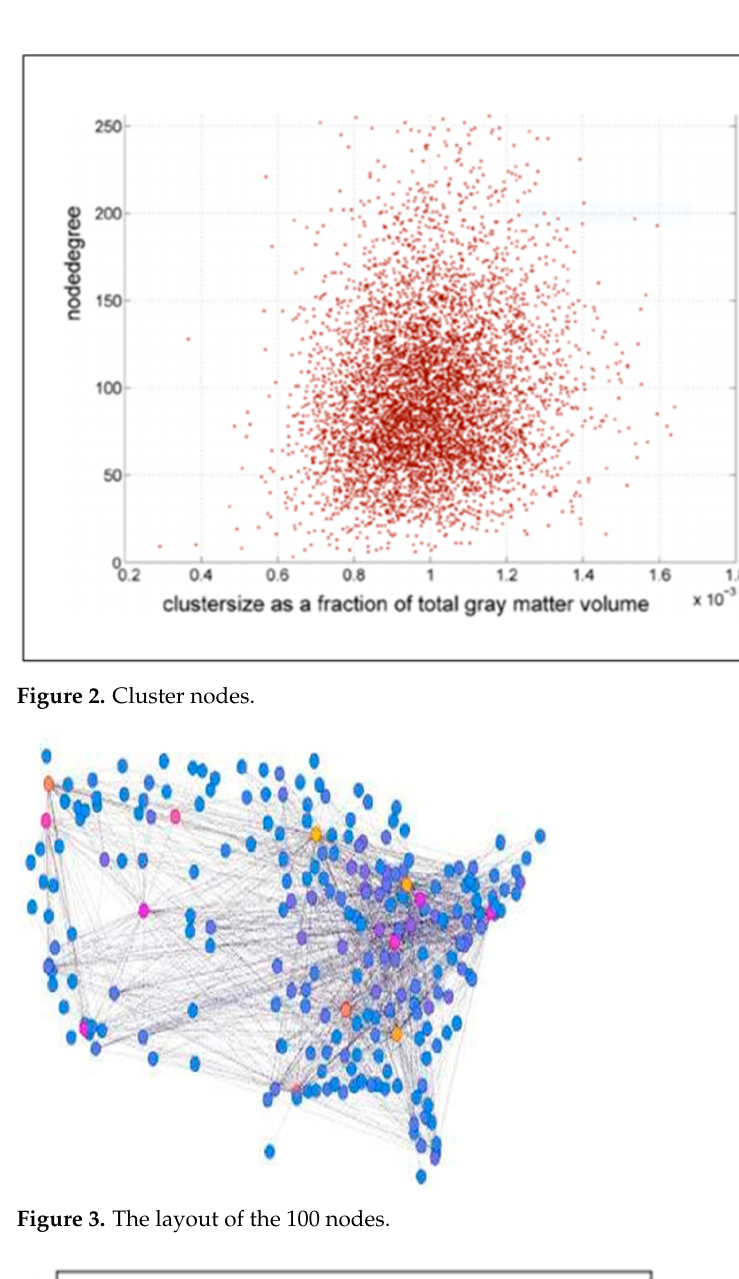
Figure 1. Distributed map of public health care centers in Chennai city, Tambaram zone.